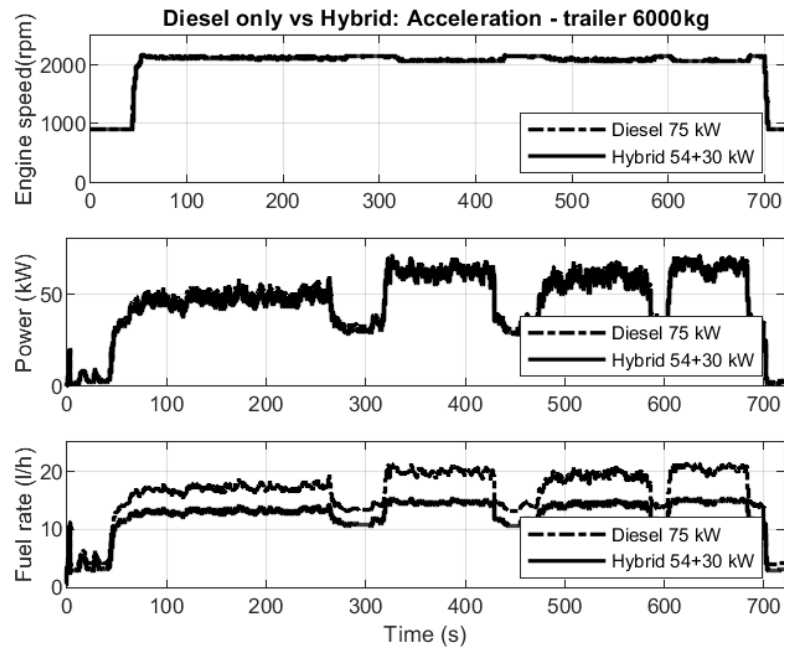
Figure 9. Hybrid vs. traditional architecture: rotary harrowing